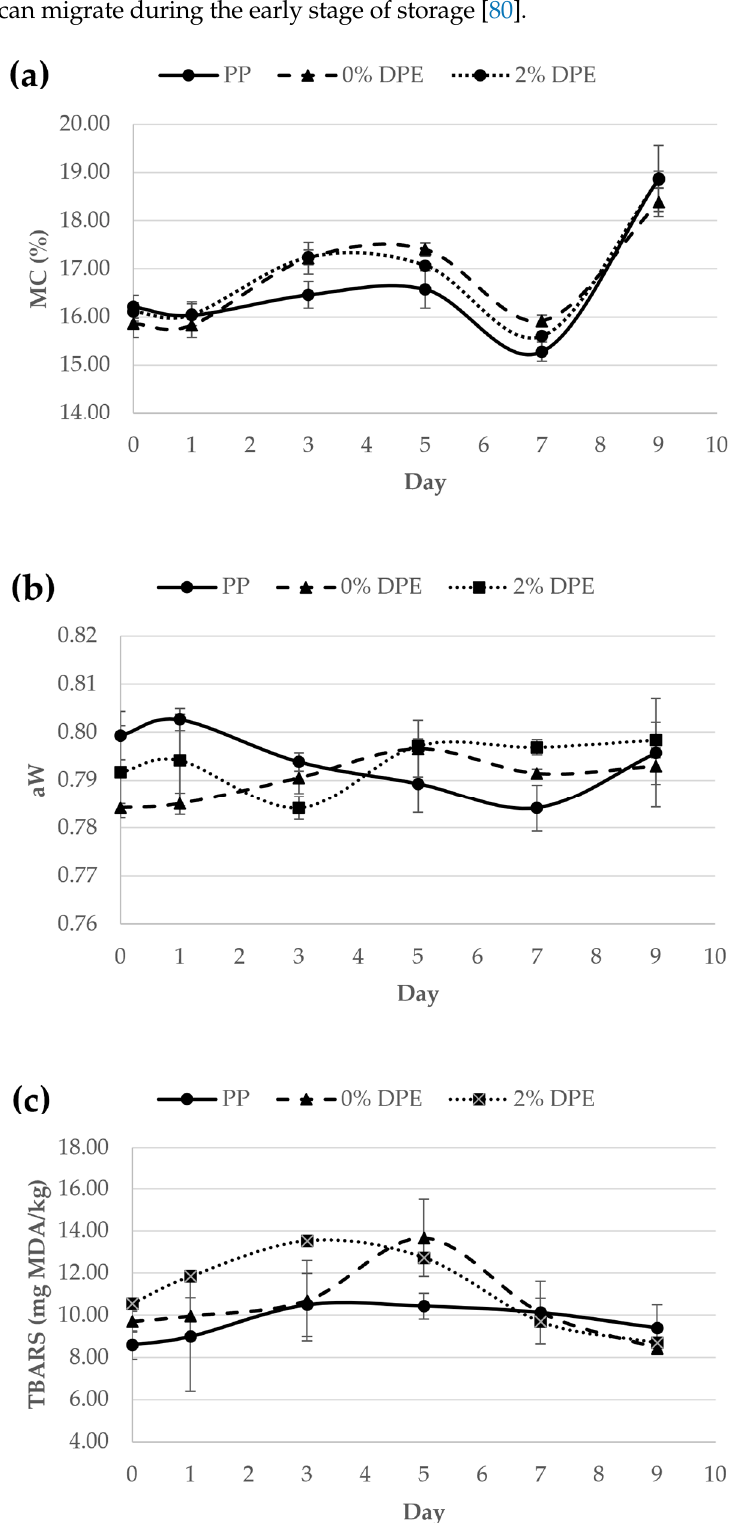
Figure 3. Moisture content ( a ), water activity ( b ), and Thiobarbituric acid reactive substances (TBARS) ( c ) of coconut milk candy wrapped in polypropylene (PP), 0% DPE biocomposite film, and 2% DPE-enriched biocomposite films (% w / v ).